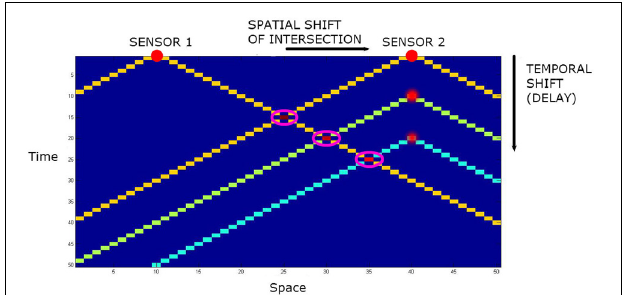
FIGURE 4 | The spatiotemporal line of sight of two audio sensors in one spatial dimension plus time. The intersections are highlighted by magenta rings. With no delay, the intersection of the lines of sight is the point equidistant from the two sensors. By adding temporal delays to one sensor, the intersection can be translated in